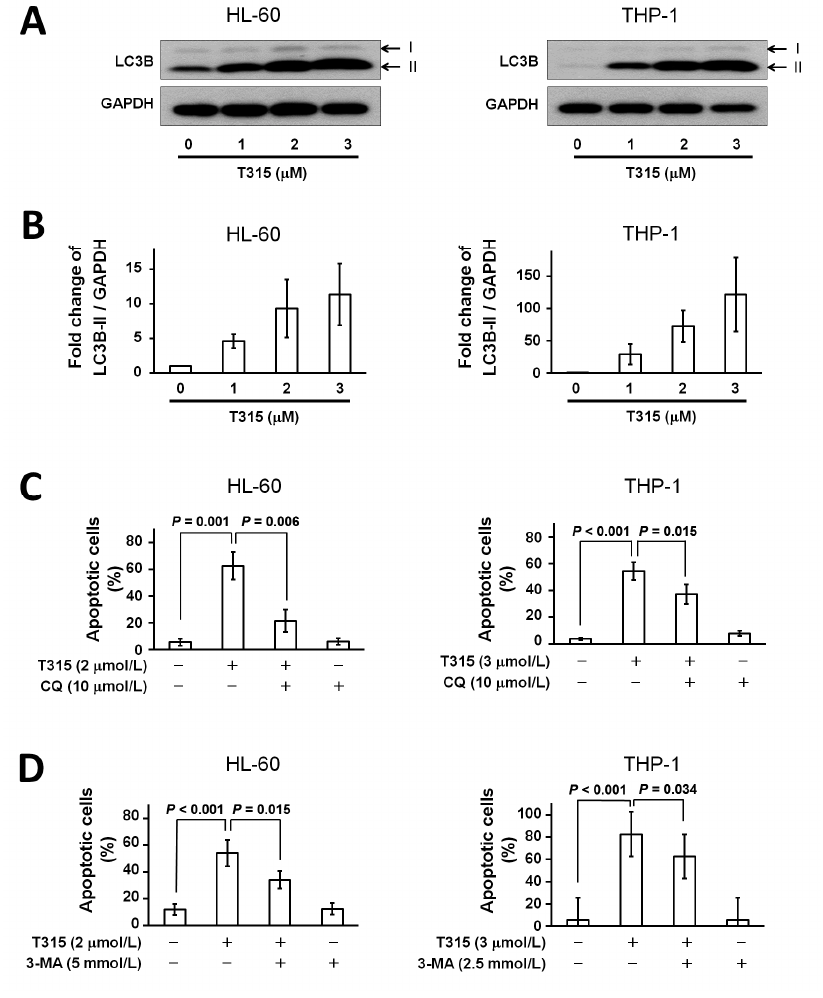
Figure 4. Cont. Figure 4.